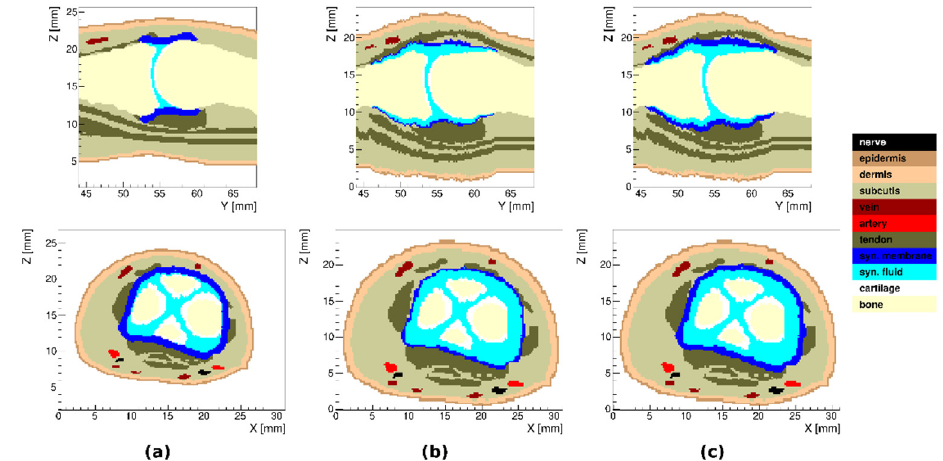
Figure 4. Sagittal and transverse cross sections of the proximal interphalangeal joint region in the model of arthritic index finger: ( a ) with synovial membrane thickening, ( b ) with synovial fluid effusion and ( c ) with both synovial membrane thickening and synovial fluid effusion.